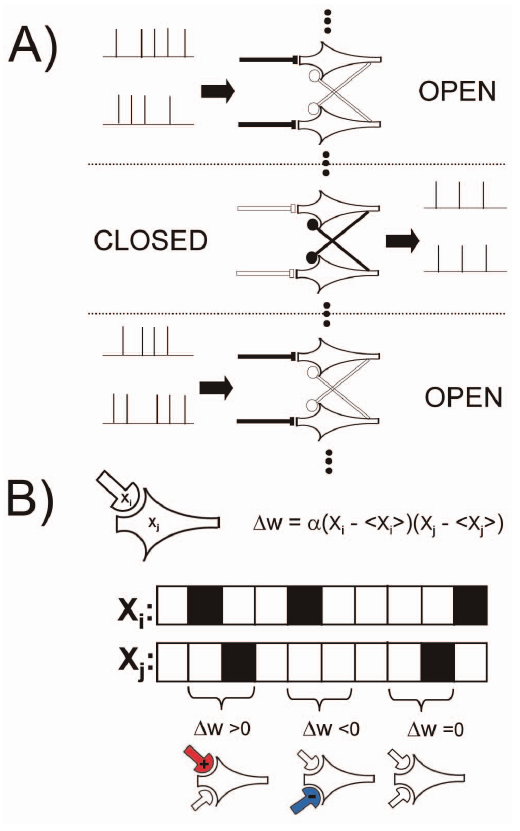
Figure 1. Synaptic state matching architecture and spike- timing dependent covariance plasticity. ( A ) Dynamical architec- ture of synaptic state switching and state matching. Neurons continually oscillate between two global network states: activity imposed by sensory input (open) and activity generated by recurrent synaptic drive, in the absence of sensory input (closed). ( B ) synaptic plasticity rule (potentiation strength) in discrete time. X i and X j are binary events corresponding to pre-synaptic and post-synaptic spikes, respectively and , X i . and , X j . are their continuous valued running averages. For an activating synapse ( + ), a pre-synaptic spike, followed immediately by a post-synaptic spike gives rise to a potential weight increase ( D w . 0). In the case of an inhibitory synapse (-), a pre-synaptic spike preceding a quiescent post-synaptic neuron gives rise to a potential weight increase ( D w , 0). Potentiation can only occur following a pre-synaptic spike. Candidate potentiation events lead to synaptic strength modulation such that the mean potentiation strength is matched between the open and closed states. As mean potentiation strength is a compact measure of the locally observed spike statistics, synaptic state matching assures that recurrent synaptic drive is recapitulating the spatiotemporal dynamics of sensory input. In this example, spikes correspond to immediate pre and post-synaptic states. In principle, each synapse can have its own axonal conduction delay, in which the presynaptic action potential arrives with a distinct latency relative to the action potential originating at the